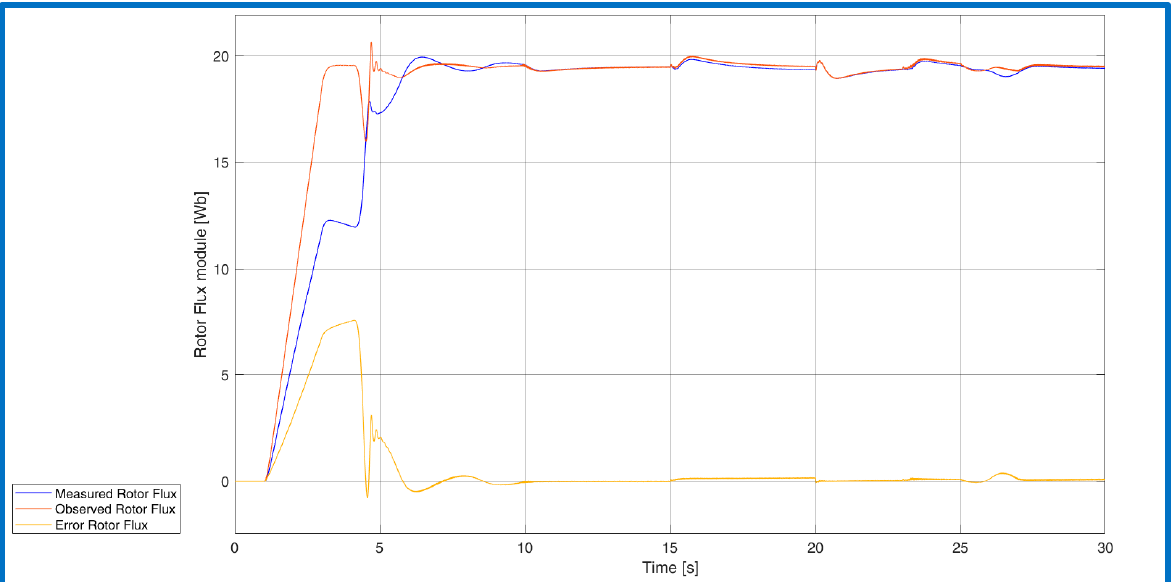
Figure 19. Real rotor flux module (blue), observed rotor flux module (red), and observer error (yellow), with inverter and continuous cable model.